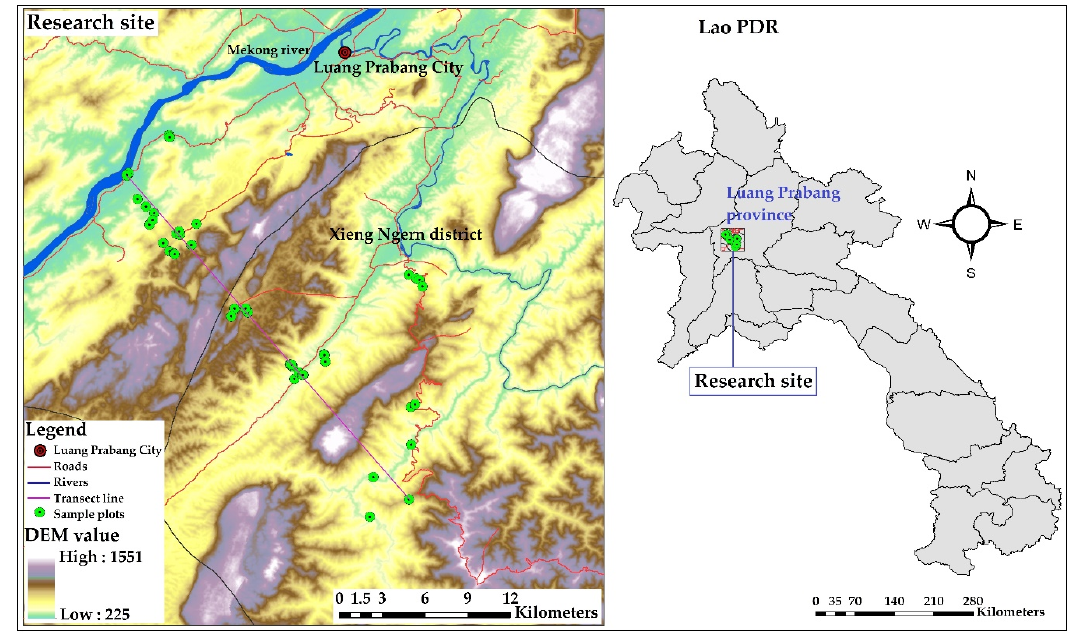
Figure 1. Map of the research site showing the transect line (pink) and the precise location within the Lao People’s Democratic Republic (PDR). Source: Drawn by the authors based on Mekong Geographic Information Systems data. DEM, digital elevation model.